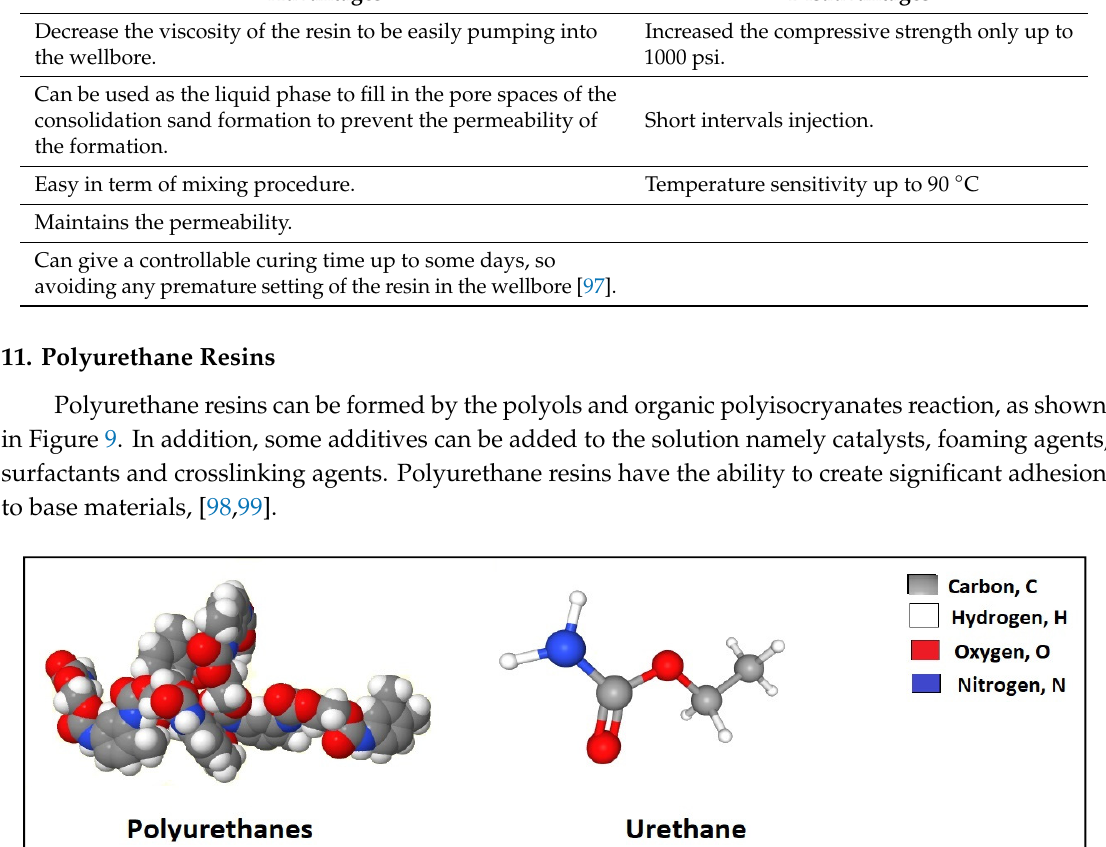
Table 18. Advantages and disadvantages of permeability enhancing additive (PEA) method.